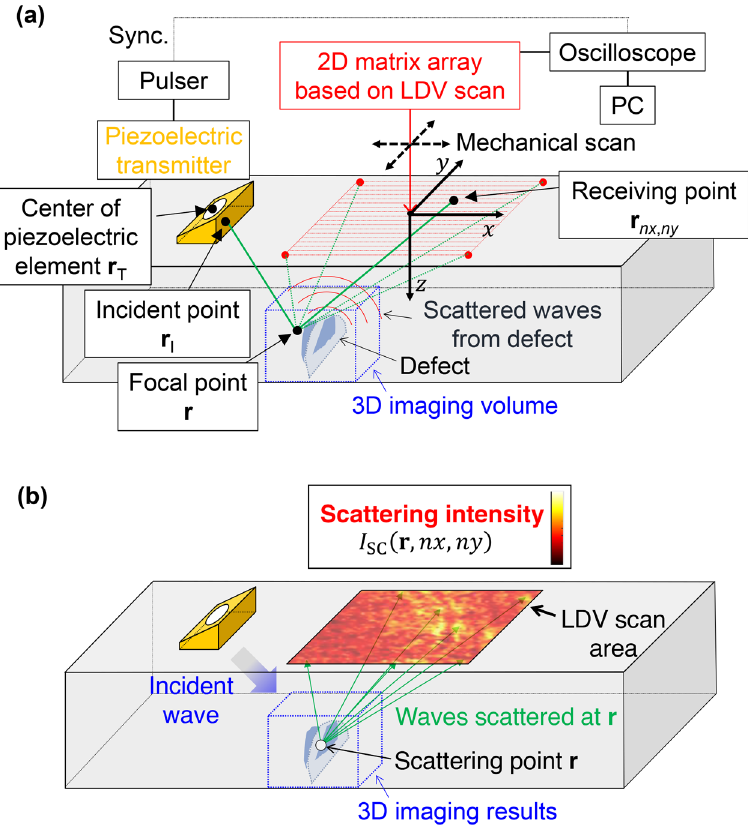
Figure 1. (Color online) Schematic illustrations of PLUS and 3D ultrasonic scattering analysis method. ( a ) 3D ultrasonic phased-array imaging system, PLUS. ( b ) Method for examining the 3D ultrasonic scattering